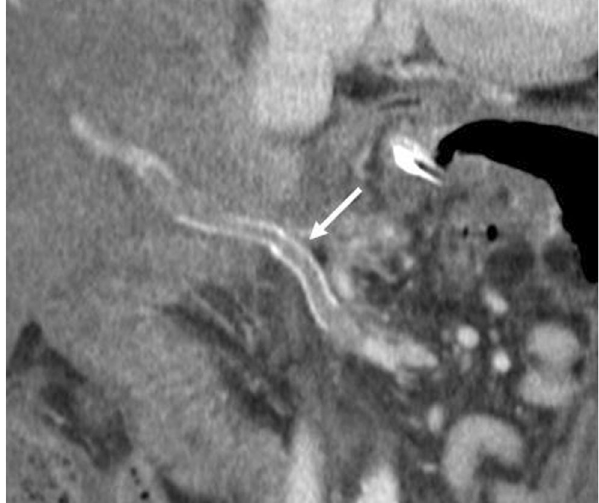
Fig. 22 Portal vein thrombosis. CT curvilinear coronal reconstruction image shows the presence of a massive thrombosis of the superior mesenteric and portal venous axis (white arrow) following a DCP with a resection of the portal vein and prosthetic